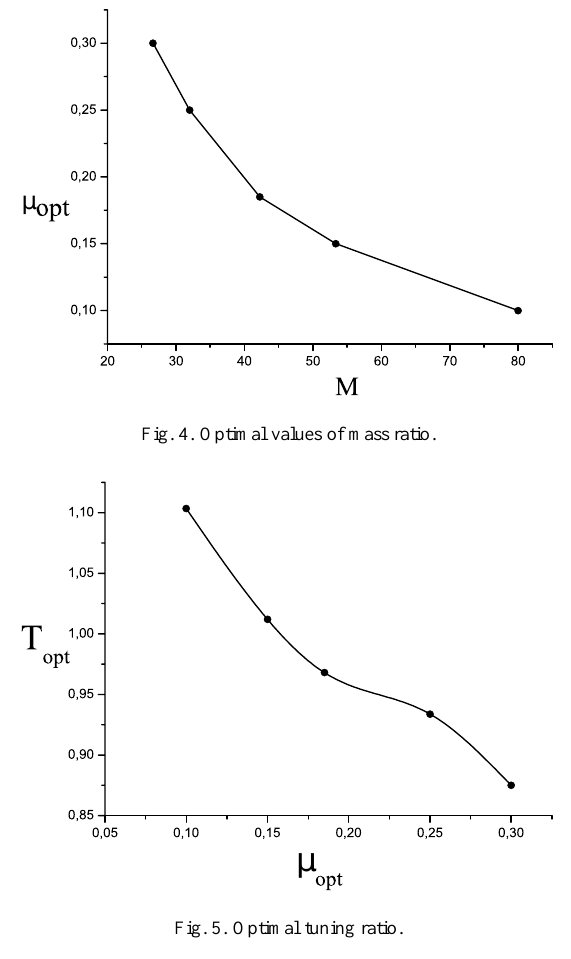
Fig. 5. Optimal tuning